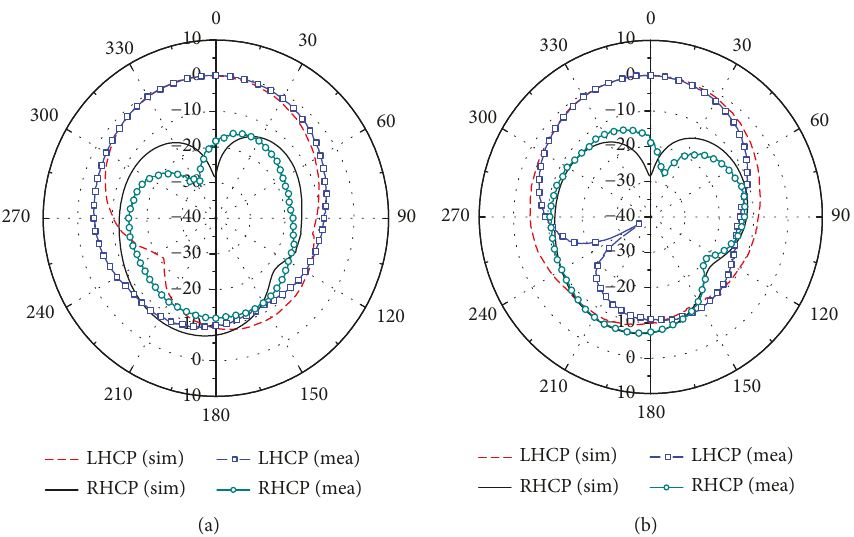
Figure 9: Simulated and measured radiation patterns: (a) xz plane and (b) yz plane.